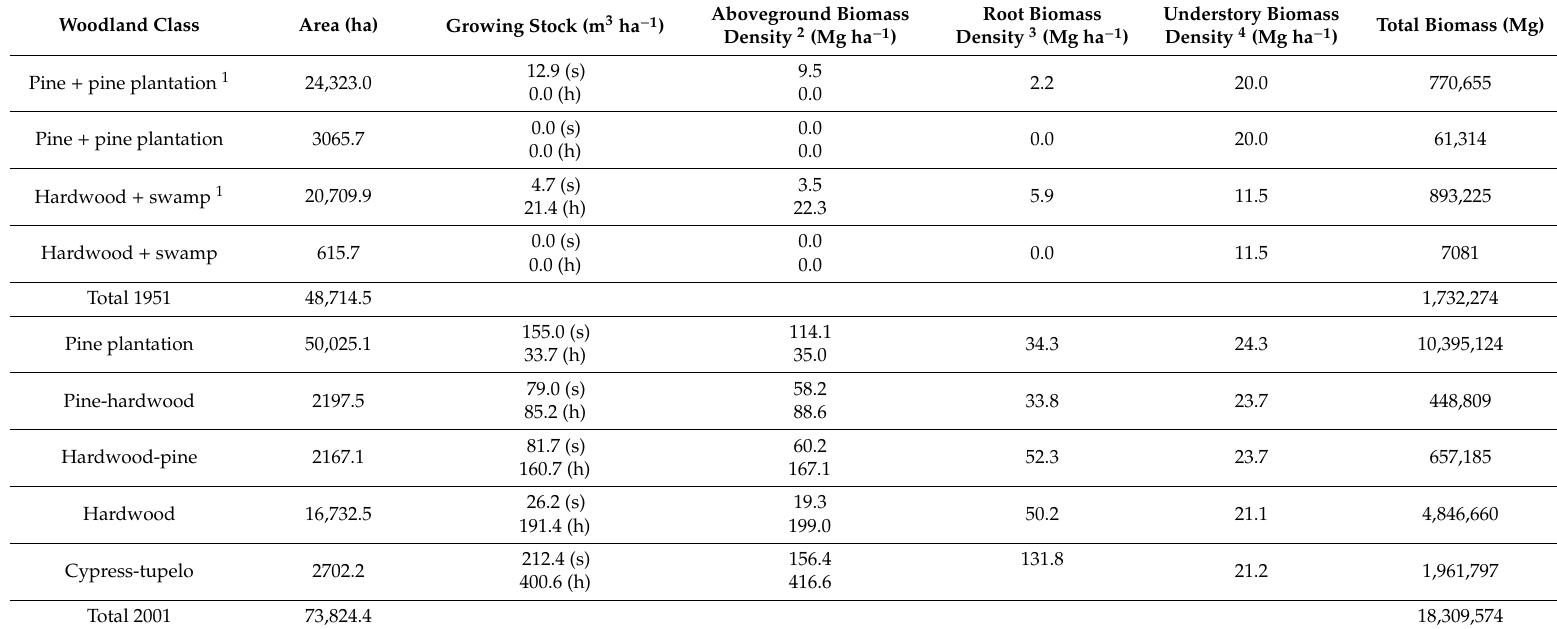
Table 2. Forest vegetation biomass density and total biomass estimates for softwoods (s) and hardwoods (h) for 1951 and 2001 using Method A [33], forest land area (Table 1) and forest understory values from (Supplementary Table S1) for 1951 and for 2001